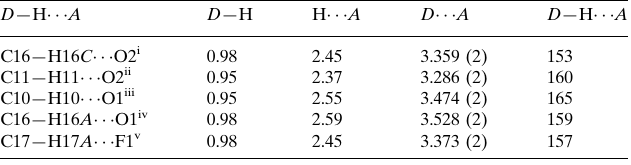
Rigaku Saturn diffractometer Absorption correction: multi-scan